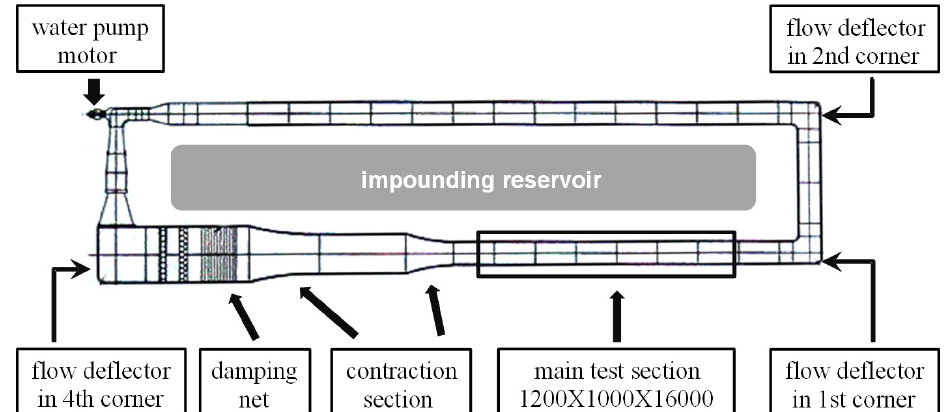
Figure 1. Configuration of water tunnel. Table 1. Properties of the test rotor.